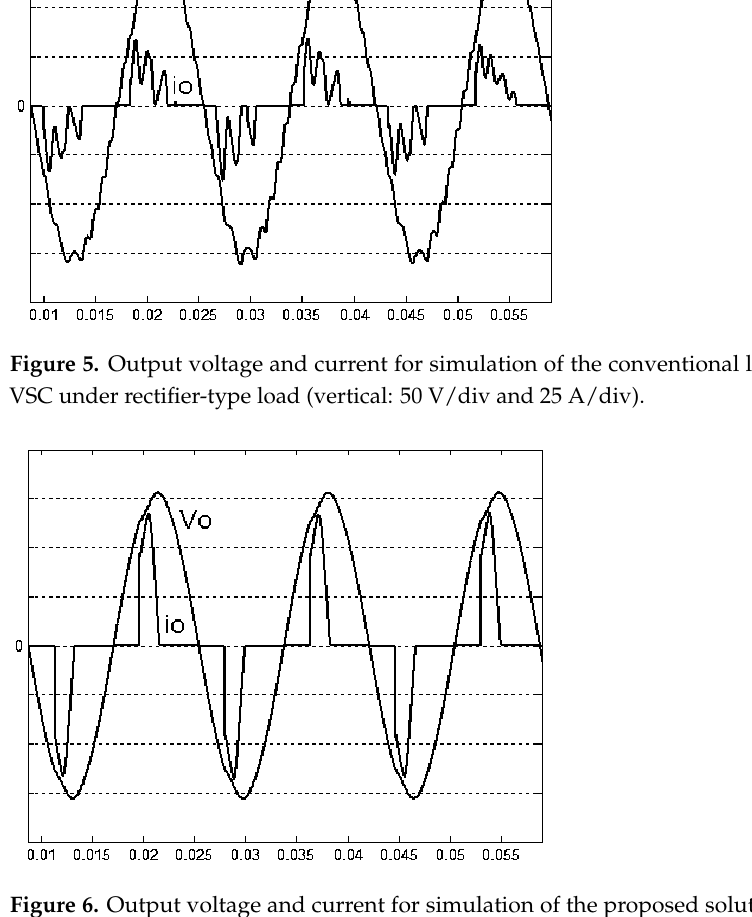
Figure 7. Output voltage and current for experiment of the conventional limited ‐ time convergent VSC at full load (vertical: 100 V/div and 20 A/div; horizontal: 5 ms/div).